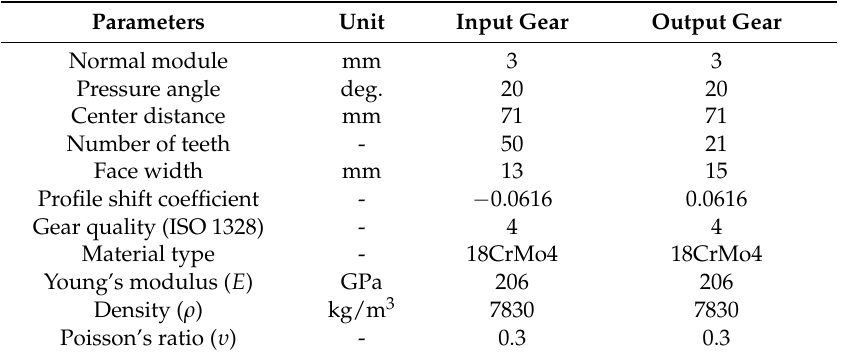
Table 2. Specifications of gear